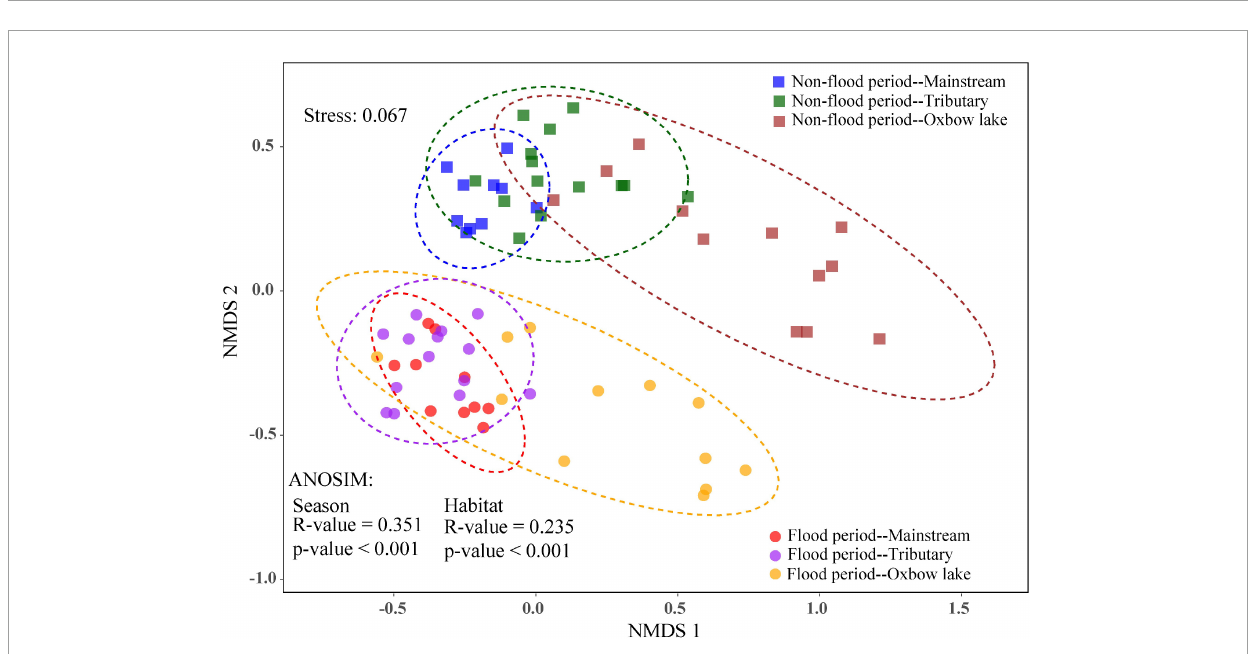
FIGURE4 Beta diversity of phytoplankton communities among different habitats in non-flood and flood periods of the White River Basin based on non-metric multidimensional scaling (NMDS) and analysis of similarities (ANOSIM).